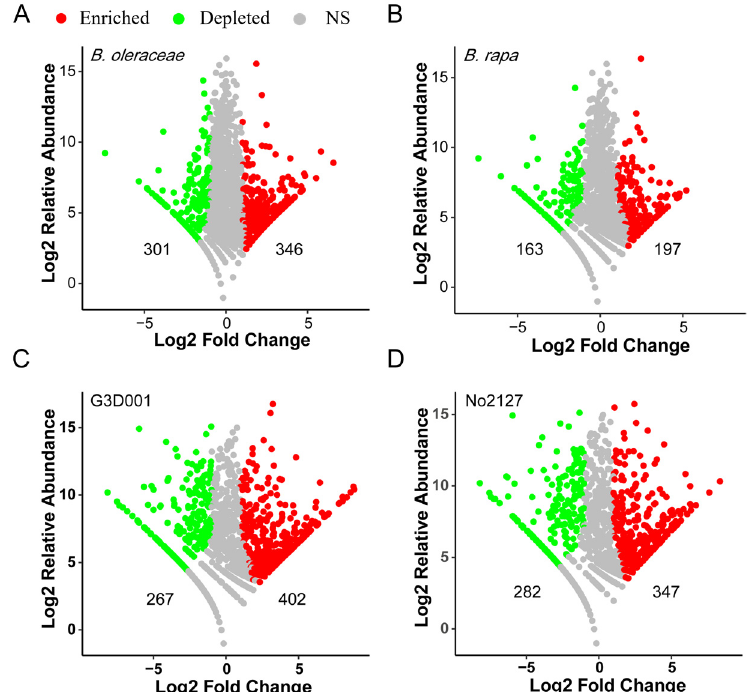
Figure 3. Enriched and depleted OTUs in B. oleracea ( A ), B. rapa ( B ) , and synthetic B. napus G3D001 ( C ) and No.2127 ( D ) relative to those in B. napus. Each point represents an individual OTU, and the position along the y-axis represents the change in average relative abundance. Numbers represent the number of enriched and depleted OTUs.